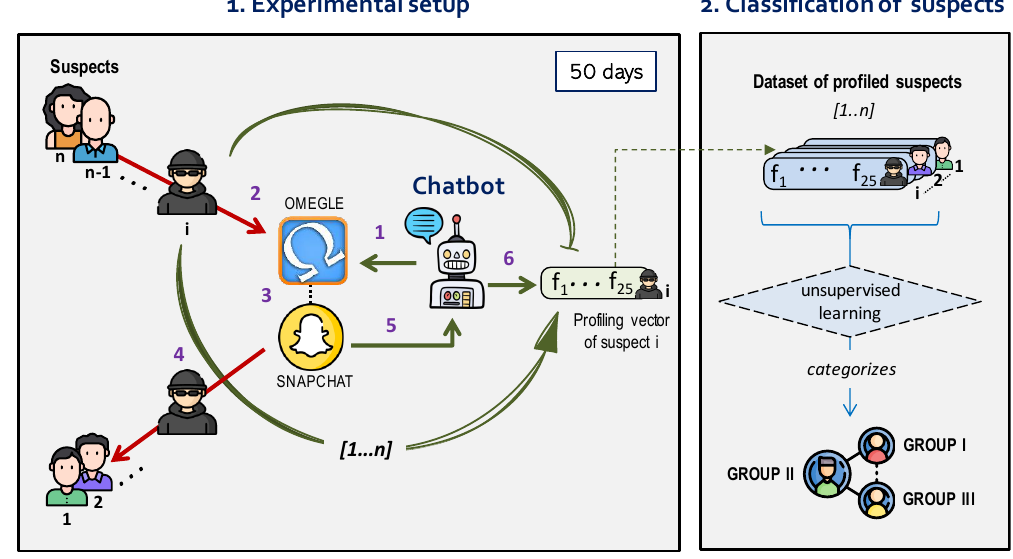
Figure 3. Experiments launched with C 3